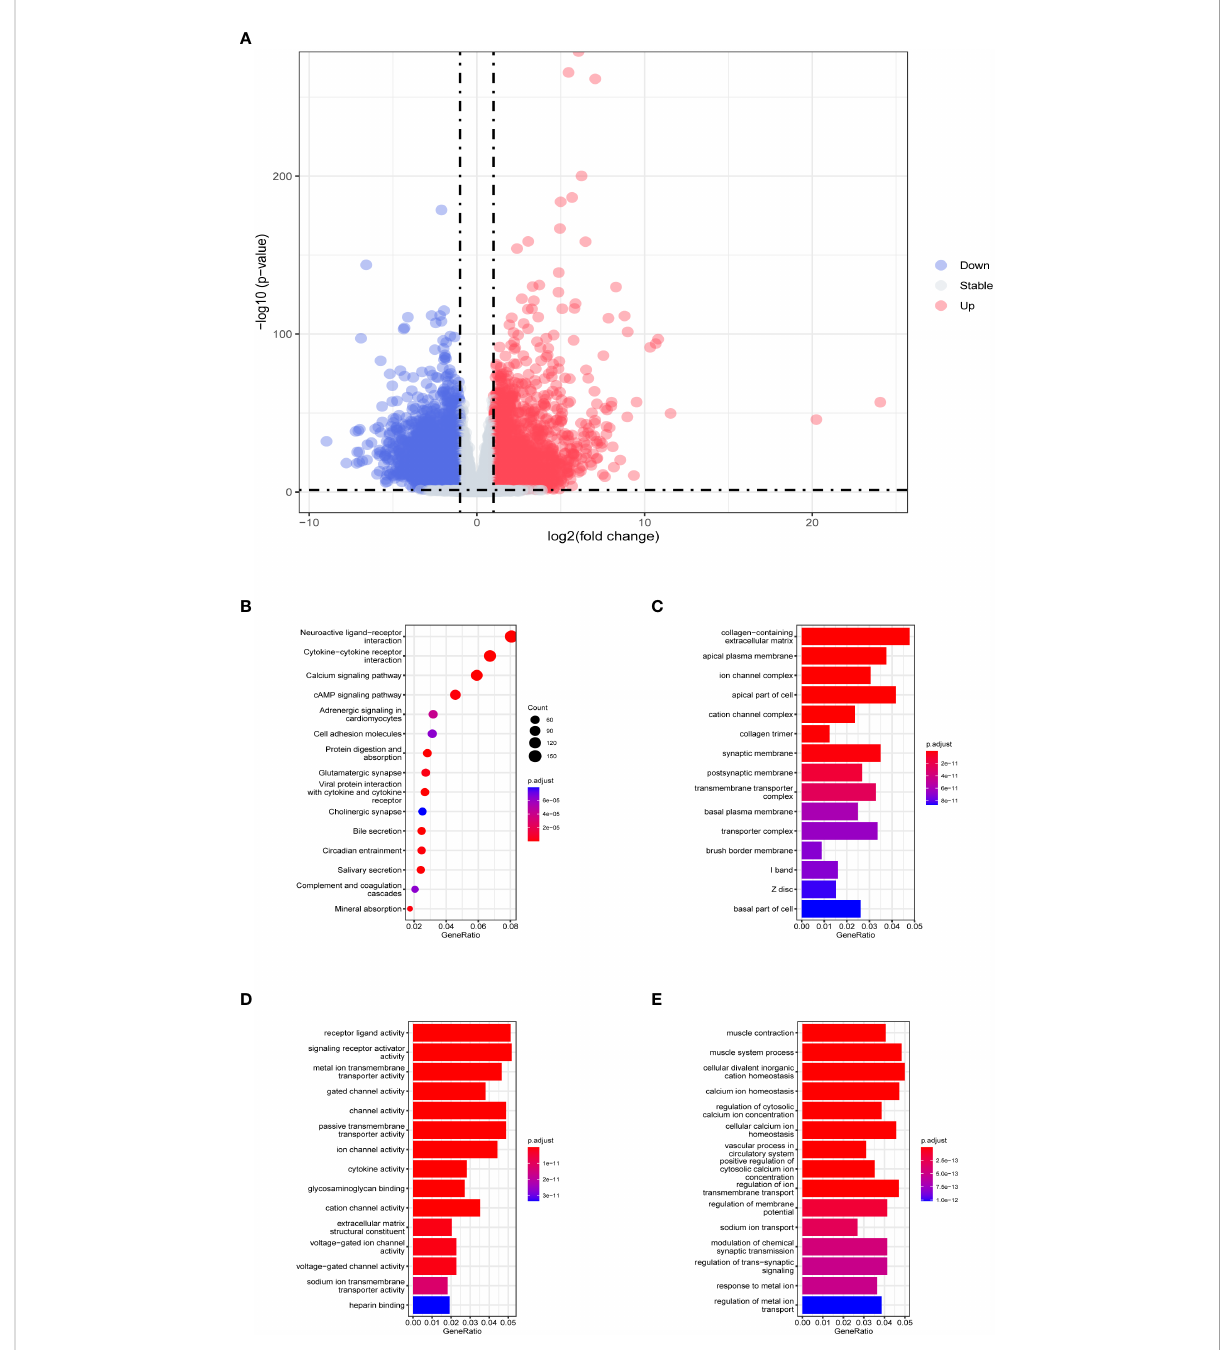
FIGURE 2 Evaluation of TCGA training dataset DEGs. (A) Volcano plot of DEGs in TCGA training dataset. The horizontal coordinate is log2 (fold change), with the distribution of genes with large differences at either end of the horizontal coordinate. The vertical coordinate is -log10 ( p -value), with larger p -values indicating more signi fi cant differences. (B) Results of KEGG analysis of DEGs. The horizontal coordinate representing the ratio of a pathway ’ s genes to the total genes. The vertical coordinate is the name of the enriched pathways. The size of the circle represents the number of genes enriched by that pathway. The color represents the p -value, the redder the color the larger the p -value. Histograms of (C) cellular component, (D) molecular function, and (E) biological process in GO analysis. The horizontal coordinate is generated, representing the ratio of a term ’ s genes to the total genes. The vertical coordinate is the name of the enriched terms. The color represents the p -value, the redder the color the larger the p